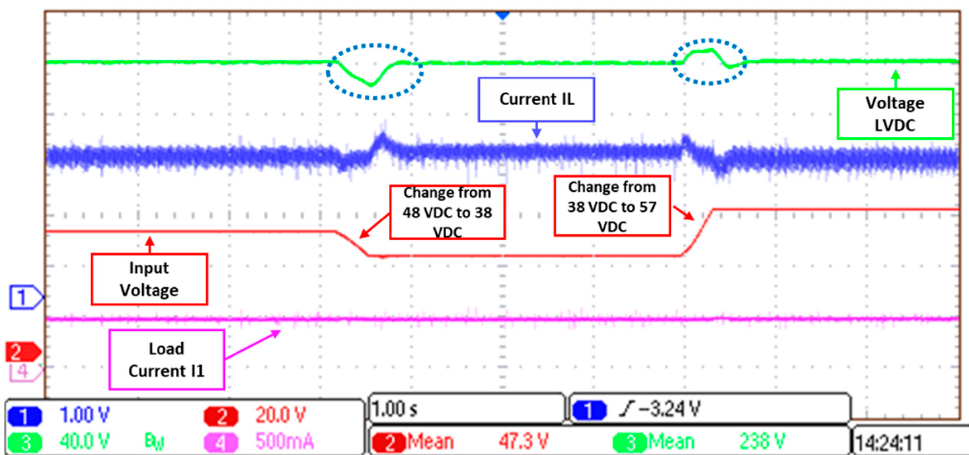
Figure 18. Experimental waveforms during validation of line regulation in boost mode.